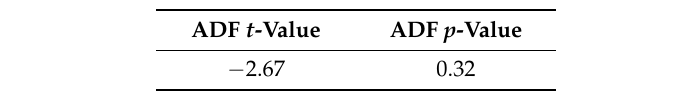
Figure 16. ADF test of cluster wise time shifted regressions. The results show that cluster wise mean-variance regressions are stationary in cluster 1 and 2. Nevertheless, cluster 3 and 4 are outliers and clusters 5 mostly covers emerging market names. Thus,